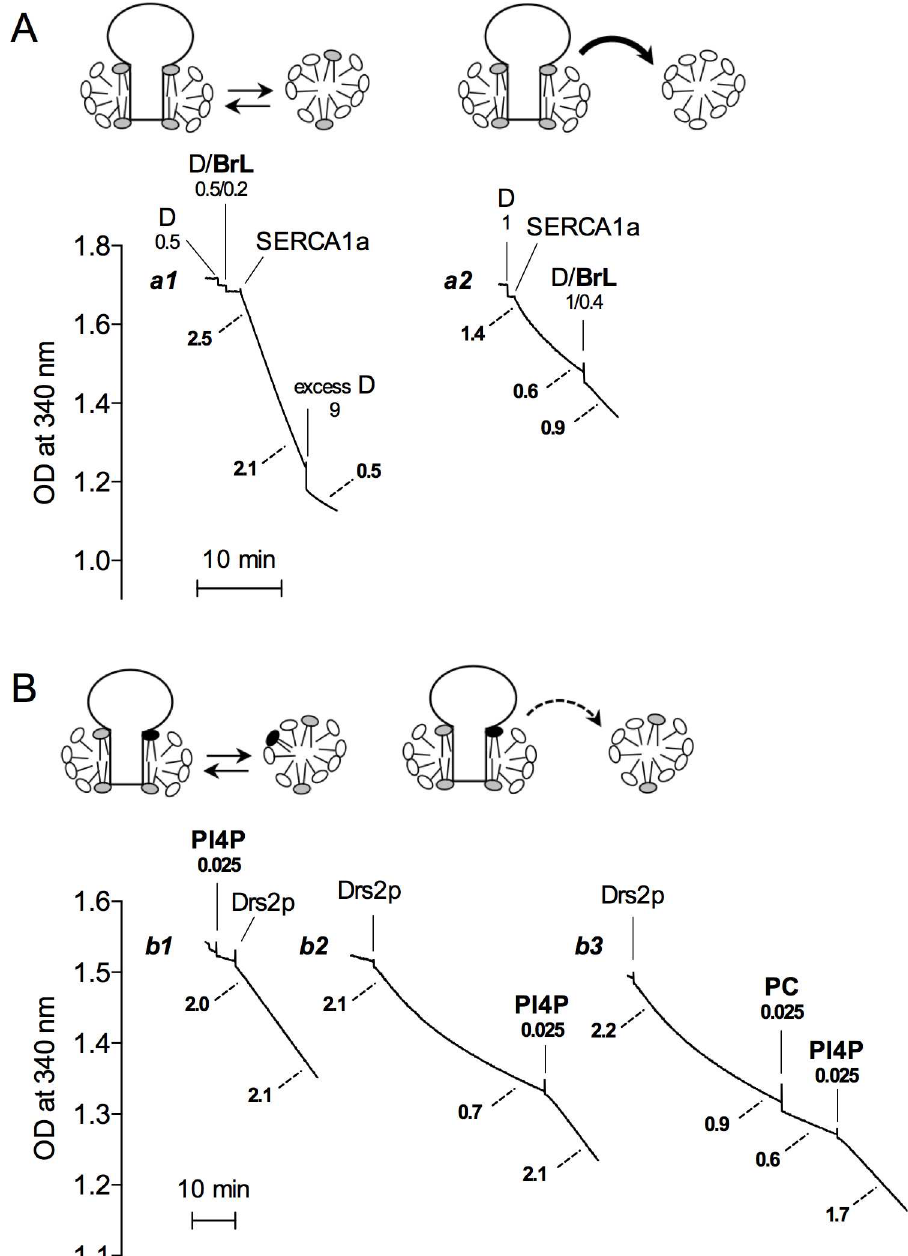
Fig 4. Slow phospholipid transfer can also be detected by functional measurements. (A) ATPase activity measurements with SERCA1a. SERCA1aat 2 mg protein/mL was solubilizedwith mixed micellesat 10 mg/mL DDM and 2 mg/mL BrPC. This solubilized enzyme was diluted 500-fold into either (Trace a1 ) buffer A to which a total of 1 mg/mL DDM and 0.2 mg/mL BrPC had been added(and excess DDM at 9 mg/mL was added at the end), or (Trace a2 ) buffer A to which 1 mg/mL DDM only had been added.In the latter case, mixed micelleswere added after some time, resultingin final concentrations of detergent and lipid twice higher than those in Trace a1 (2 mg/mL DDM and 0.4 mg/mL BrPC), but at the same detergent/lipid ratio. ATPase activity was measuredat 20˚C. The cartoon on top depicts the principleof the experiment. Lipids and detergentmoleculesare representedwith grey and white headgroups,respectively. (B) ATPase activity measurements with purifiedand chymotrypsin-treatedDrs2p/Cdc50p complex. To be able to reveal the ATPase activity of the complexusing the enzyme-coupledassay, we first subjectedthe purifiedDrs2p/ Cdc50pto limited proteolysis with chymotrypsin in the presenceof DDM, PS and PI4P (see Materials and Methods). This treatment relieves auto-inhibition of Drs2p/Cdc50p, increasingsignificantly its ATP